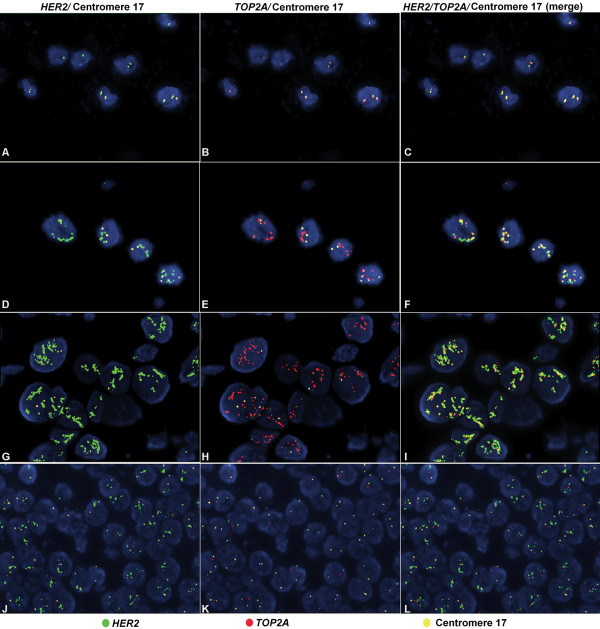
Fluorescence in situ hybridization (FISH) in breast cancer cell lines and invasive breast carcinomas (IBC). FISH in breast cancer cell lines (A-F) and IBC cases (G-L) for the HER2 and TOP2A genes using the HER2/TOP2A/CEN17 triple color probe. The MDA-MB-231 cell line showed normal status of the HER2 and TOP2A genes (A-C), whereas in the SK-BR-3 cell line, co-amplification of the HER2 and TOP2A genes was found (D-F). IBC case showing simultaneous amplification of the HER2 and TOP2A genes (G-I); IBC case with amplification of the HER2 gene, deletion of the TOP2A gene and normal chromosome 17 status (J-L). Panels A, D, G and J show HER2 and centromere 17 hybridization signals; Panels B, E, H and K show TOP2A and centromere 17 hybridization signals, where as panels C, F, I and L depict merged HER2, TOP2A and centromere 17 signals. Magnification x1000.